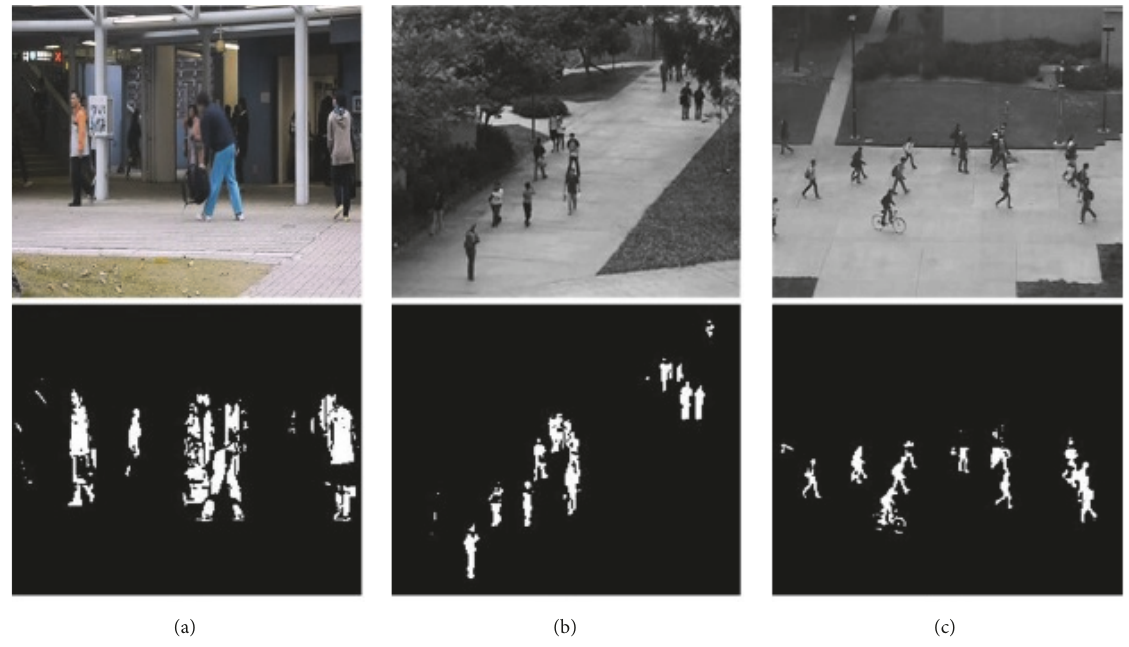
Figure 1: Segmented foregrounds using a Block-RPCA from (a) Avenue, (b) Ped1, and (c) Ped2 datasets.